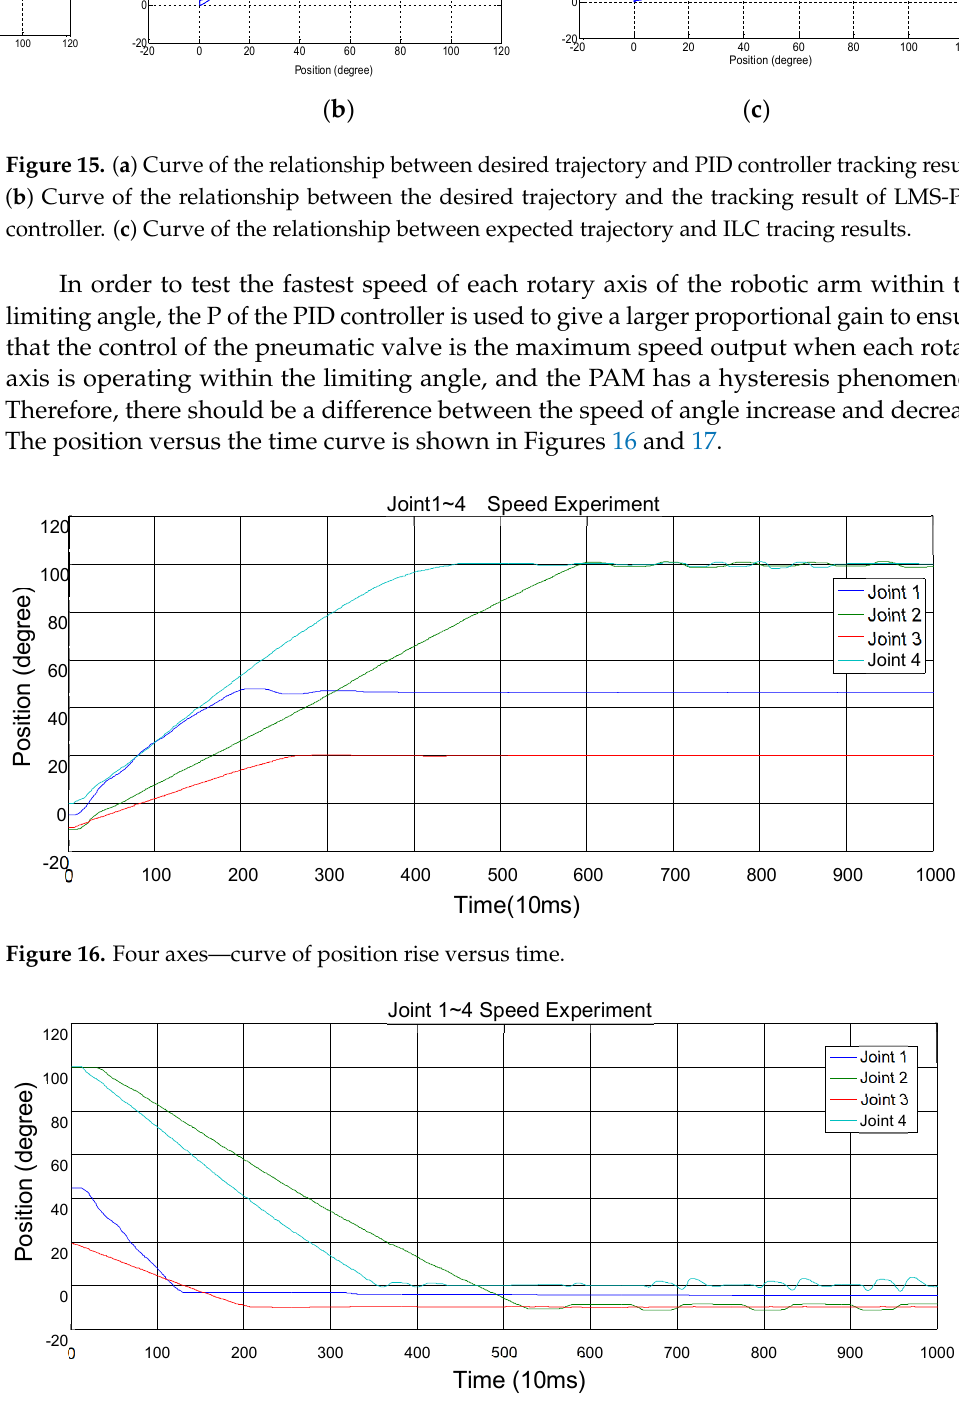
Figure 17. Four axes—curve of position drop versus time.